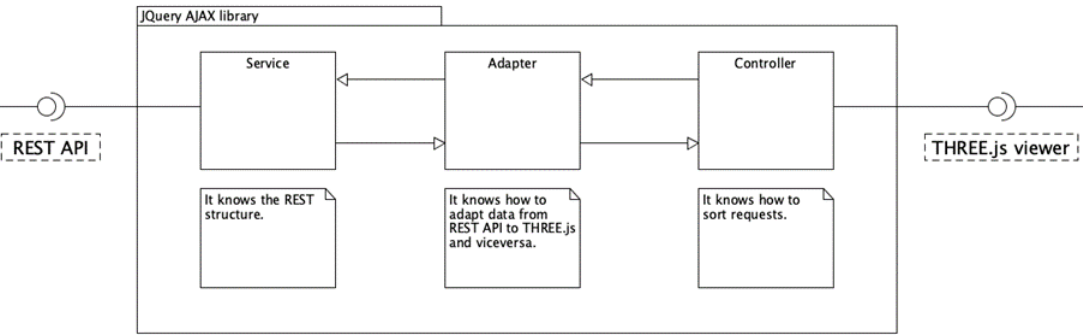
Figure 4. JQuery AJAX library description.